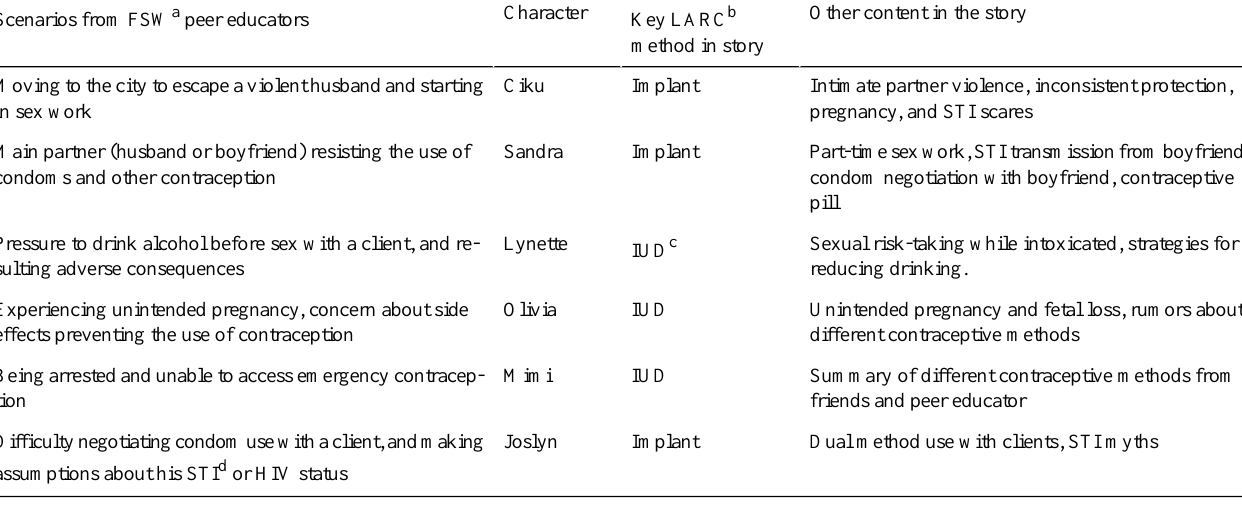
Table 2. Role model stories developed from peer educator consultation.